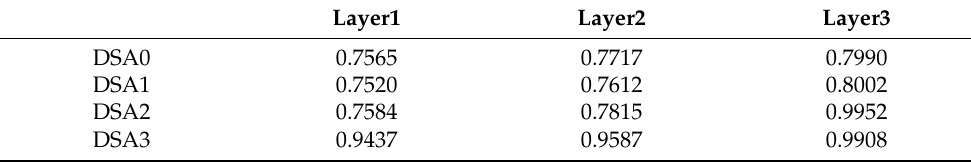
Figure 13. ROC curves of using DSAs on corner case data detection. ( a ) Layer1. ( b ) Layer2. ( c ) Layer3. Table 3. AUC-ROC of DSA-based corner case data detection on casting defect